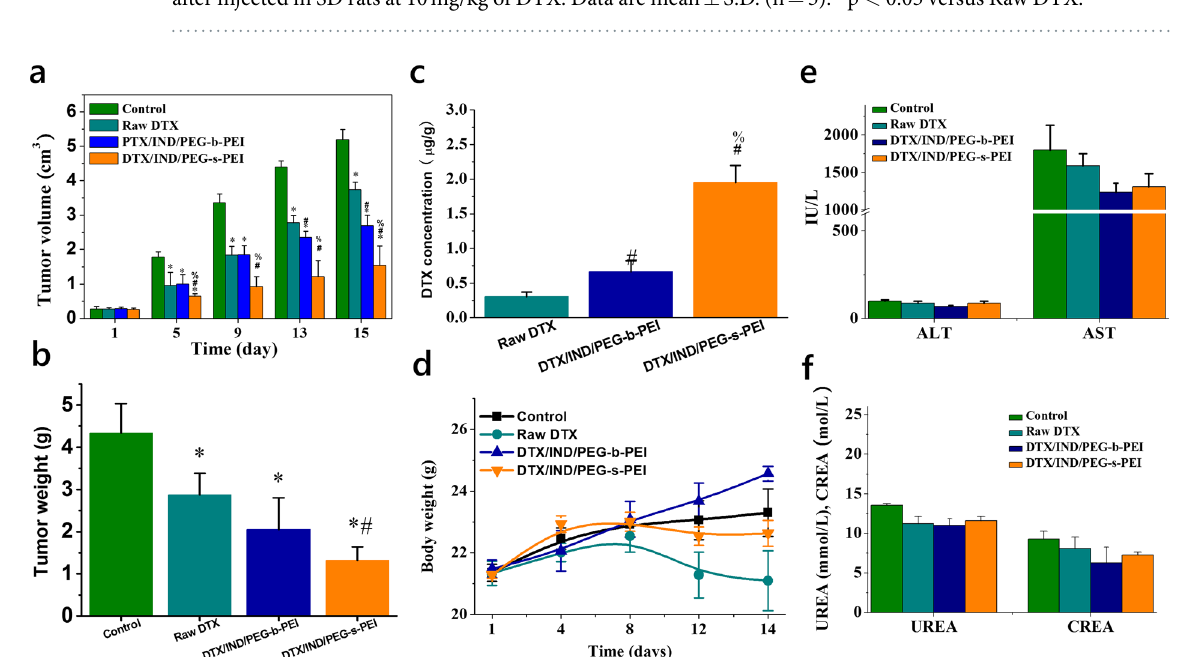
Figure 6. Improved therapeutic performance of DTX loaded nanomedicines. ( a ) Changes in the tumor volume of mice during the treatment. ( b , c ) The weight ( b ) and DTX concentration ( c ) of tumors excised from mice bearing melanoma xenografts 14 days after treatment with different DTX microspheres by oral gavage at 10 mg/kg of DTX every four days. ( d ) Changes in the body weight of mice during the treatment. ( e , f ) Typical biochemical markers relevant to liver ( e ) and kidney ( f ) functions. In all images, data are mean ± S.D. (n = 6). * p < 0.05 versus the model control; # p < 0.05 versus Raw DTX; and % p < 0.05 versus